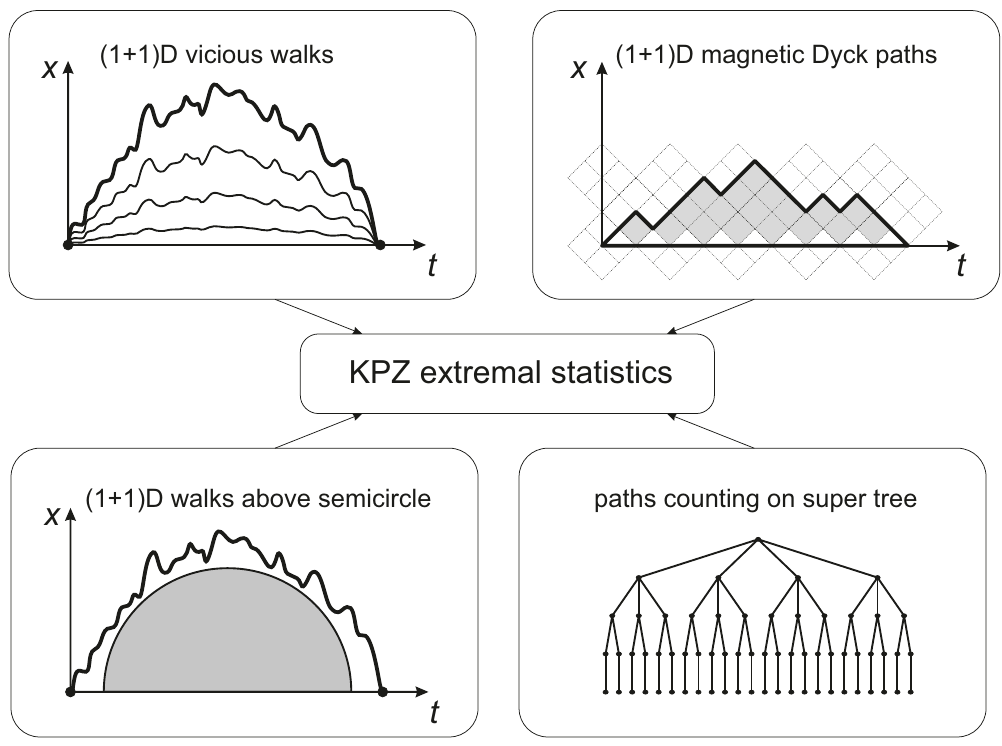
Figure 5 . KPZ scaling, appearing in a set of interconnected models: vicious walks, directed paths evading the semicircle, \in(cid:13)ated" magnetic Dyck paths, closed paths on descending super